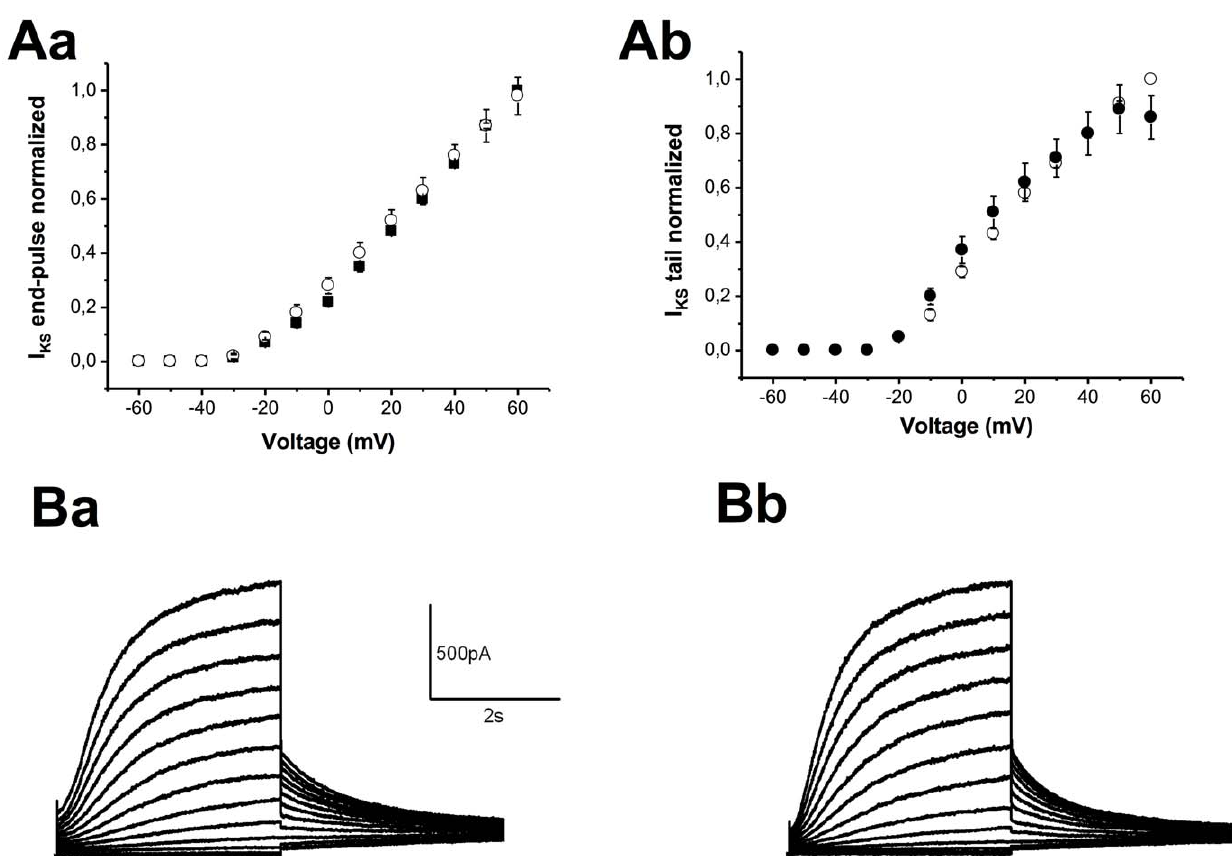
Figure 7. Effect of 3 m M C16-CAR on I KS . A, I KS -V curves of the current at the end of the pulse ( Aa ) and peak tail current ( Ab ) . B, Typical examples of families of currents in the absence ( Ba ) and presence of C16-CAR ( Bb ).